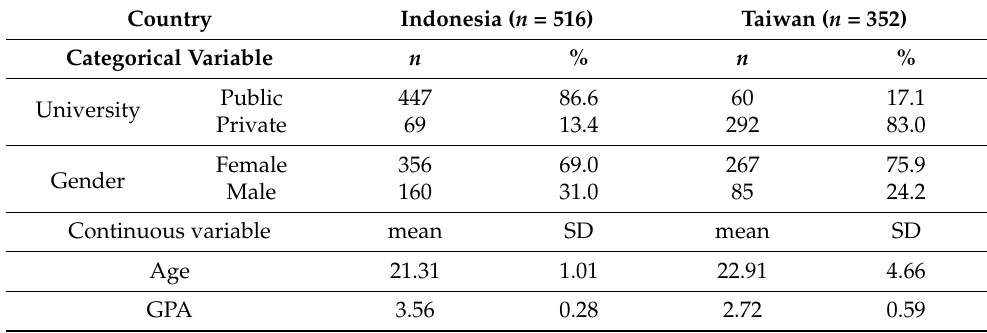
Table 2. Characteristics of survey